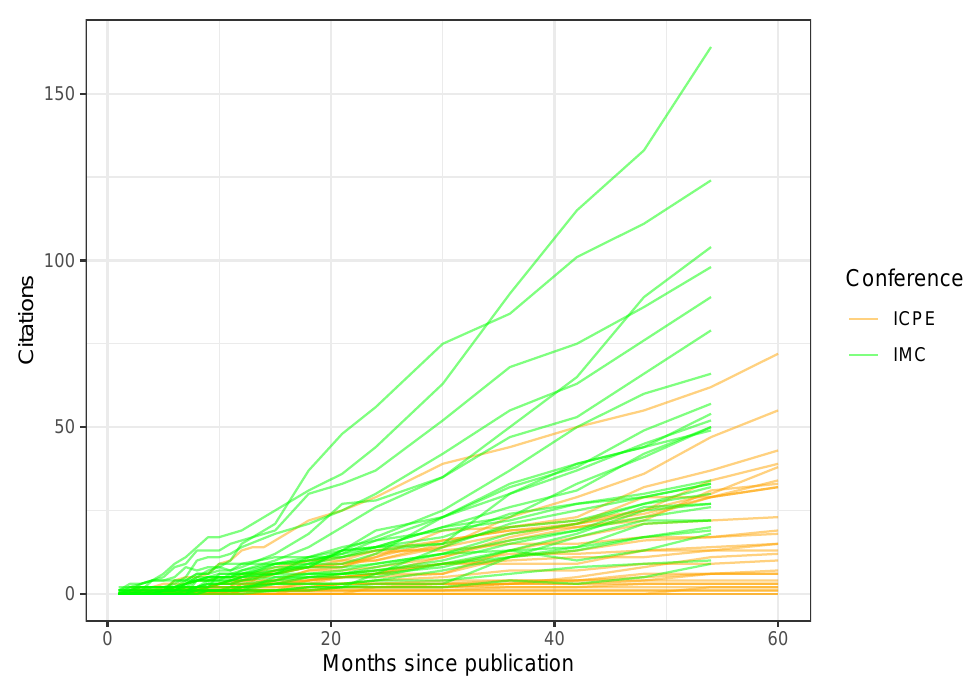
Figure 4. Total citation growth for ICPE and IMC, sampled